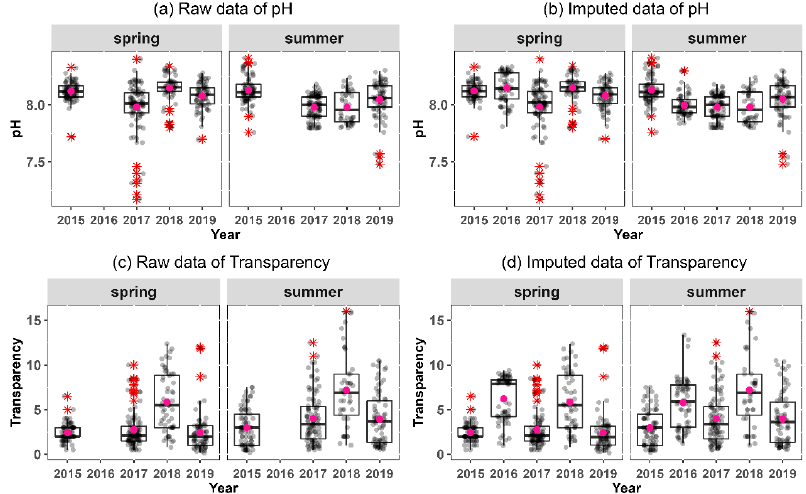
11 of 18 Figure 7. Exploratory data analysis; ( a ) correlation matrix plot, ( b ) loading plot of PCA. Abbrevia- tions: Wtemp, water temperature; pH, hydrogen ion concentration in water; DO, dissolved oxygen; SPM, suspended particulate matter; POC, particulate organic carbon; PON, particulate organic ni- trogen; DSI, dissolved silicate; DIP, dissolved inorganic phosphorus; DIN, dissolved inorganic ni- trogen; Chl- a , chlorophyll- a concentration. 3.4. Distribution of Features before and after Imputation Figure 8 shows the results before and after imputation for pH and transparency with missing values from the spring and summer 2016 surveys. During the 2015–2019 survey period, the East Korea coastal zone, southeast coastal zone of Korea, and Jeju coastal zone,